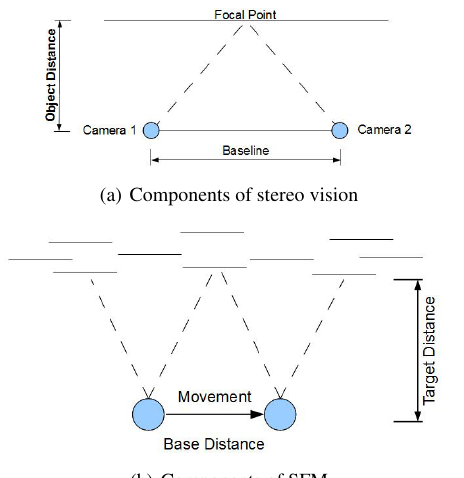
Figure 1: Components of photogrammetry